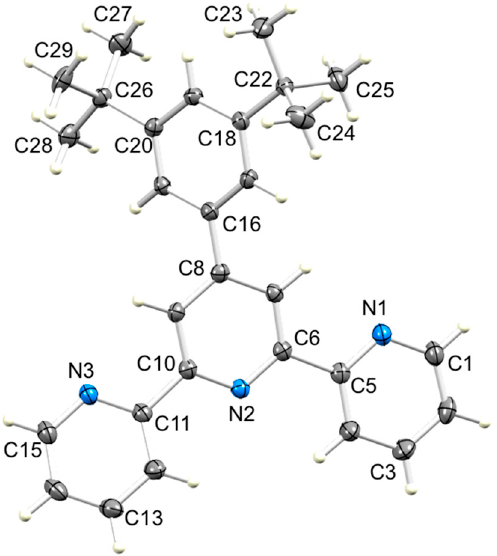
Figure 7. ORTEP-style diagram of molecule 6 in the solvated compound 6 . EtOH with ellipsoids plotted at 50% probability level. Selected bond parameters: N1–C1 = 1.3391(12), N1–C5 =